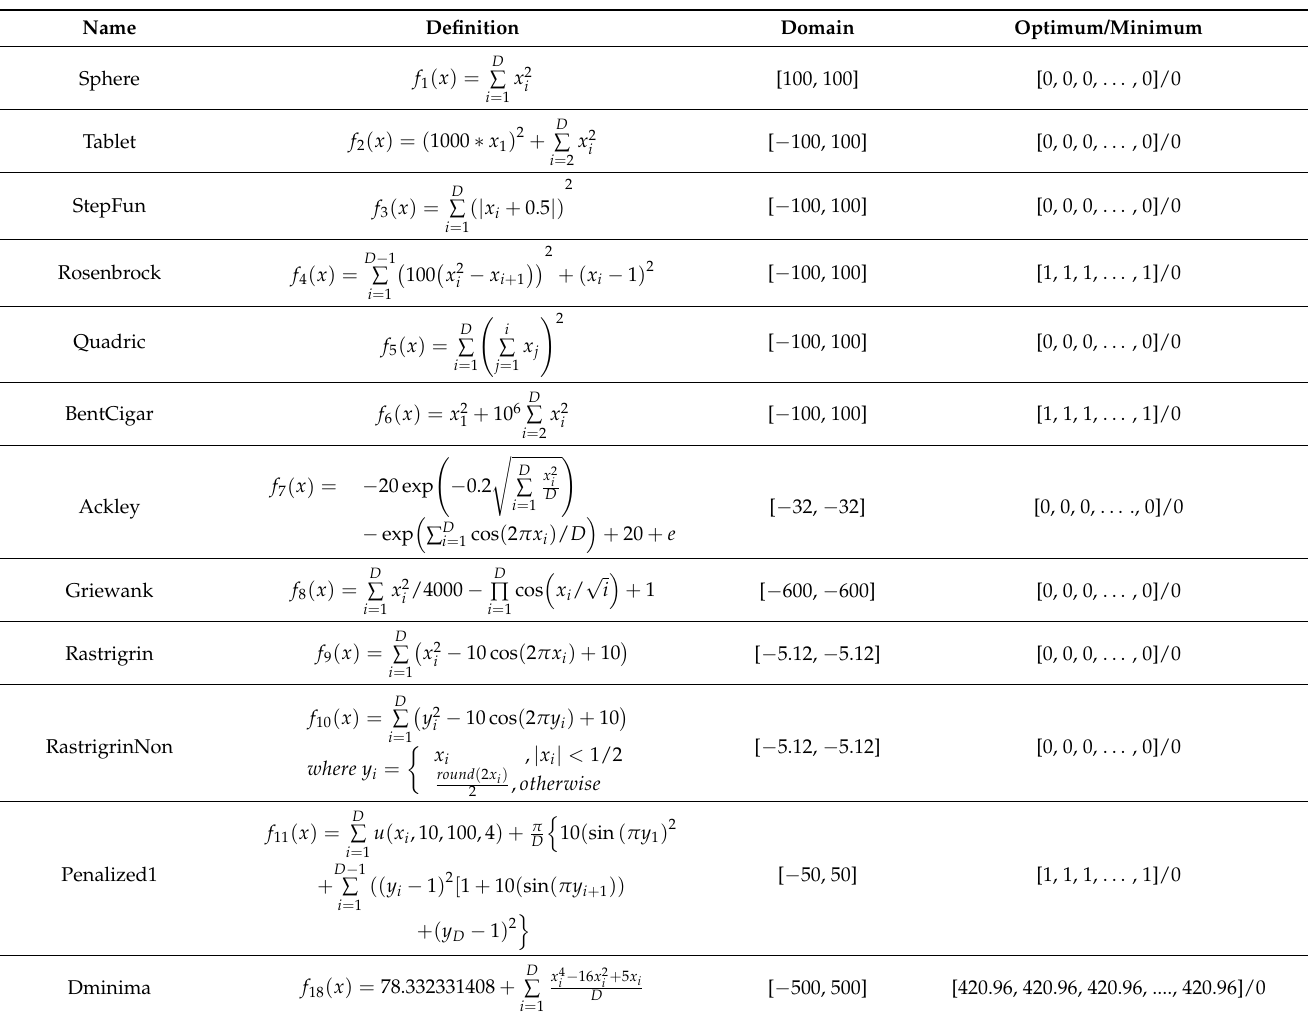
Table 3. Twelve benchmark